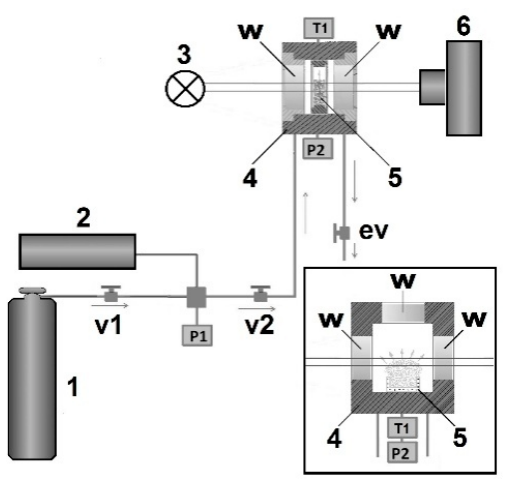
Figure 1. The scheme of the experimental setup used for a foaming of the D,L-polylactide. 1—carbon dioxide tank; 2—high-pressure pump; 3—illumination source; 4—two-window high-pressure cell with sapphire glass windows (w); 5—insertion cuvette, 6—CMOS camera with the macro-lens; v1, v2—high-pressure valves; ev—exhaust valve; P1, P2—pressure gauges; T1—temperature sensor. Inset: multi-window cell used for quasi-isothermal foaming (4); 5—glass container with polylactide. The grey arrows in the working volumes of reactors indicate directions of the foam expansion.